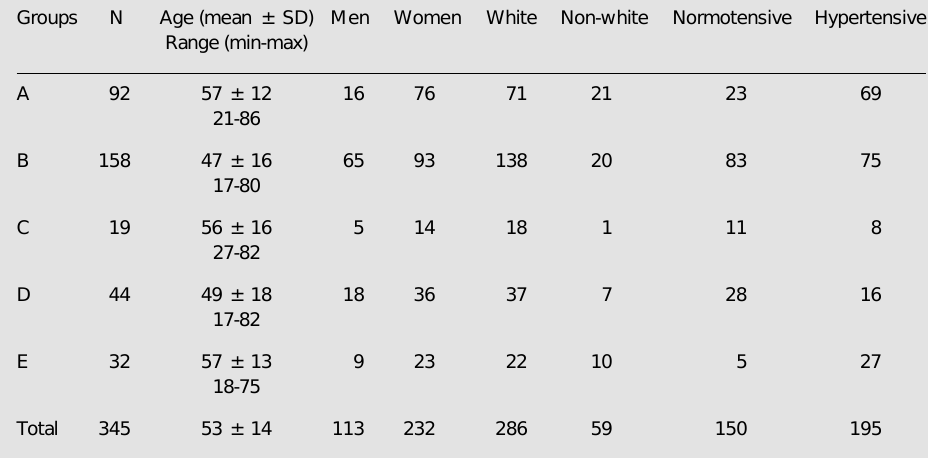
Table 2. Analysis of the difference in mean fluctuation between two pairs of blood pressure measurements (systolic and diastolic) with and without a 60-s interval between them. Group